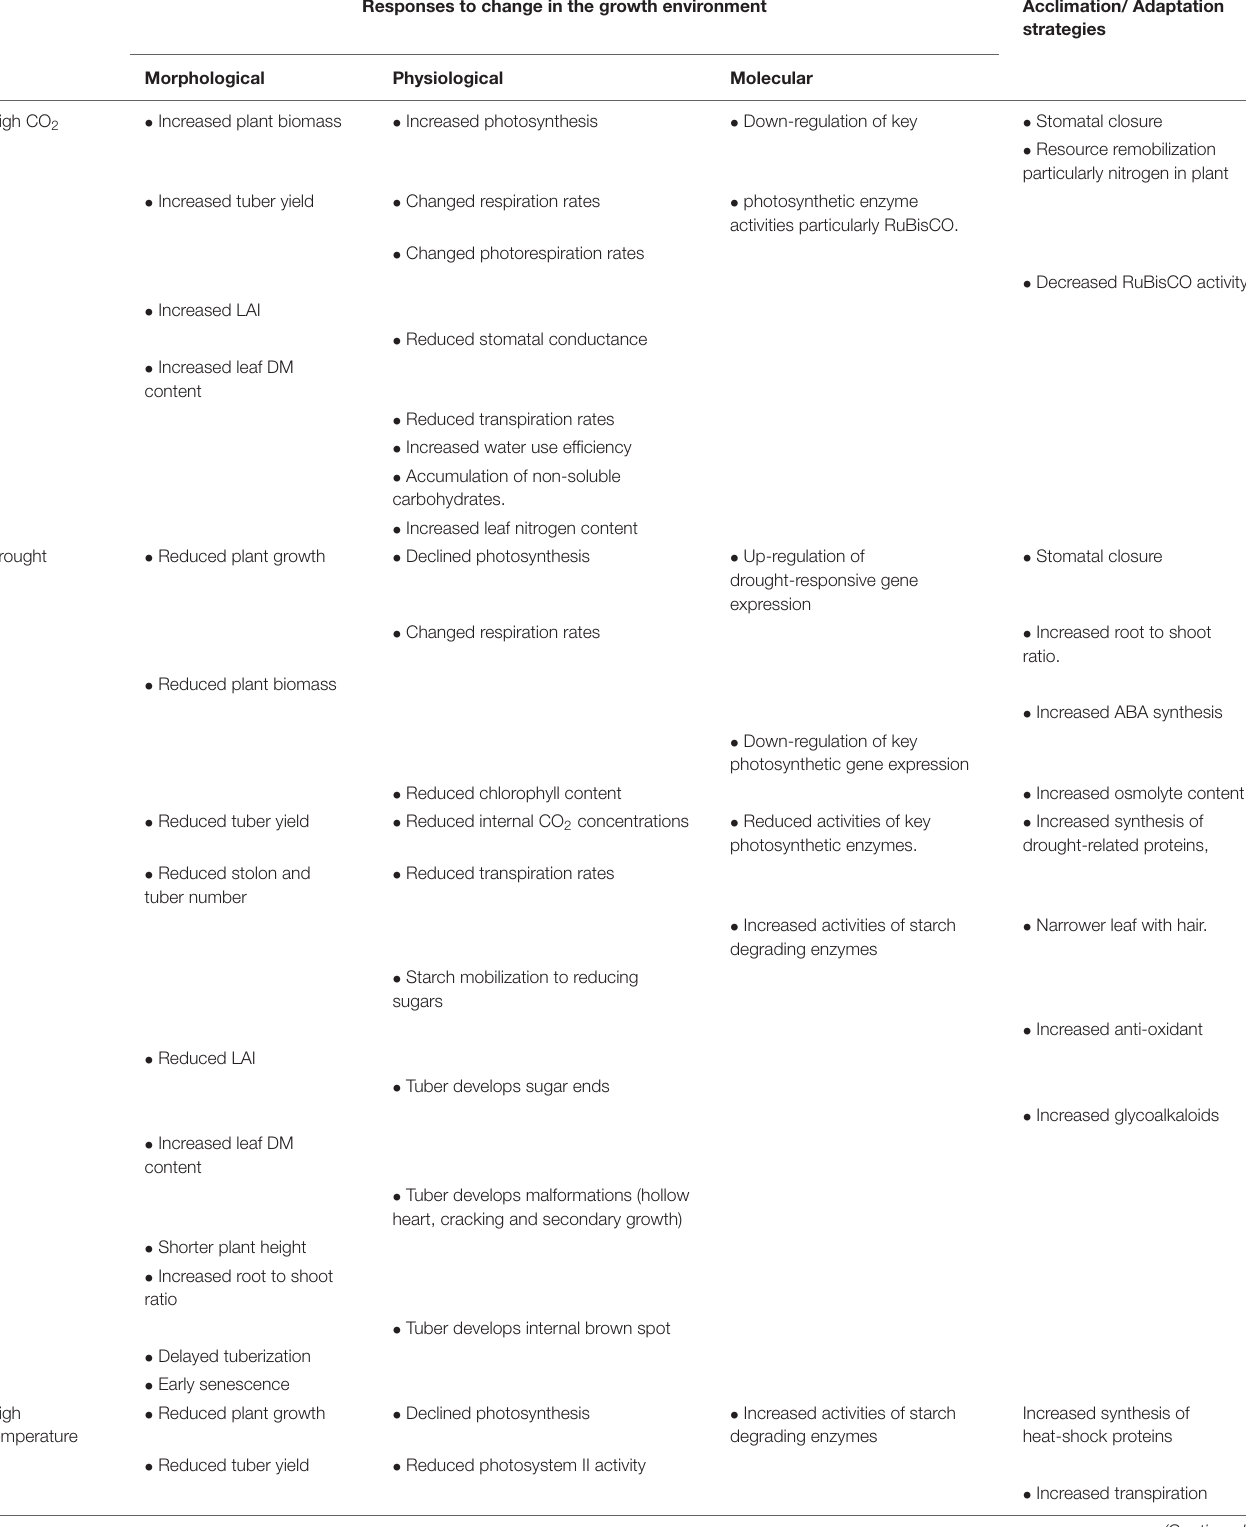
TABLE 1 | Summary of the effects of elevated CO 2 , drought, high temperature and salinity on physiological, morphological and molecular characteristics of potato and acclimation/adaptation